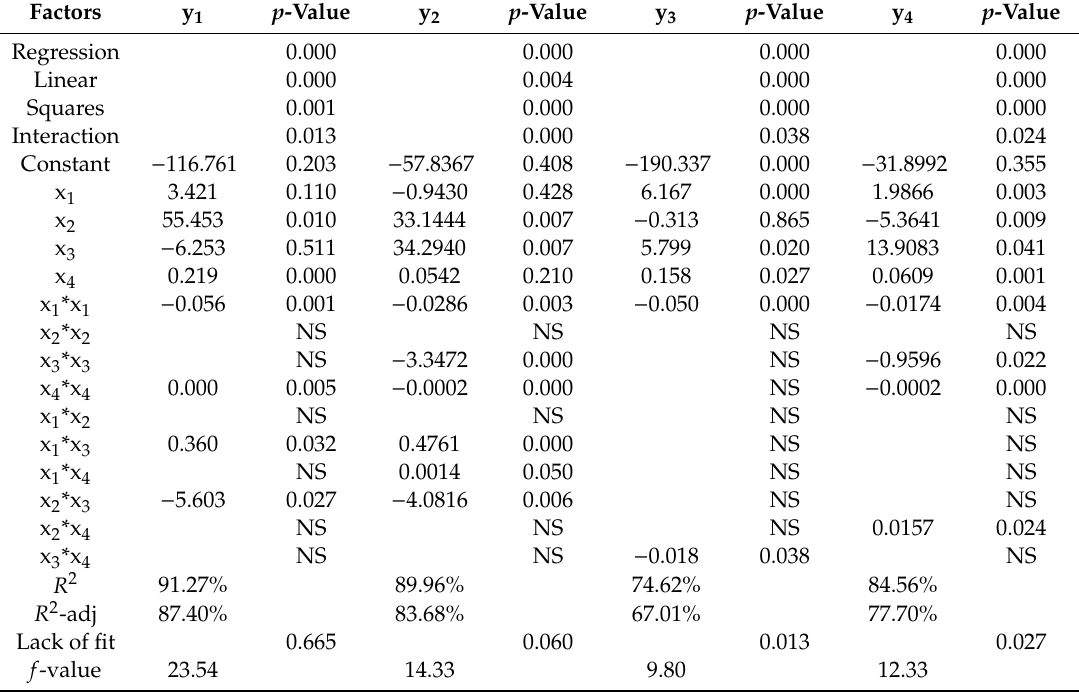
Table 3. Of variance at p < 0.05 and regression coe ffi cients for DH (y 1 ), ACE inhibition (y 2 ), DPPH • (y 3 ) and ferrous ion chelating activity (y 4 ), expressed in full quadratic models.